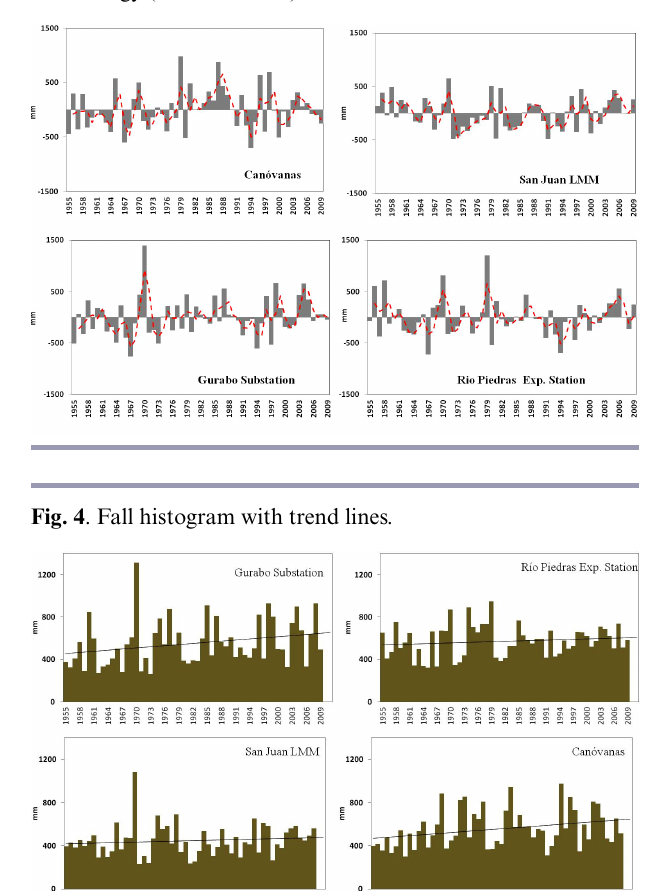
Fig. 5 . Dry days trends in San Juan metropolitan area. DJF